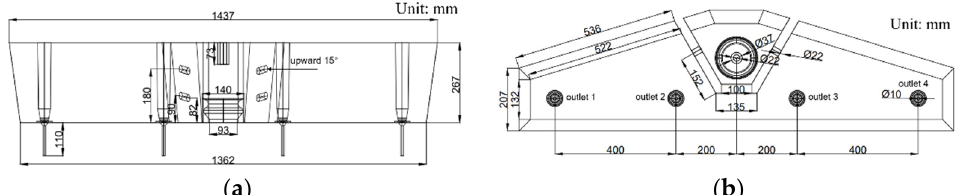
Figure 2. Two-dimensional drawing of u-shaped weir and four-strand tundish, ( a ) front view, ( b ) top view.